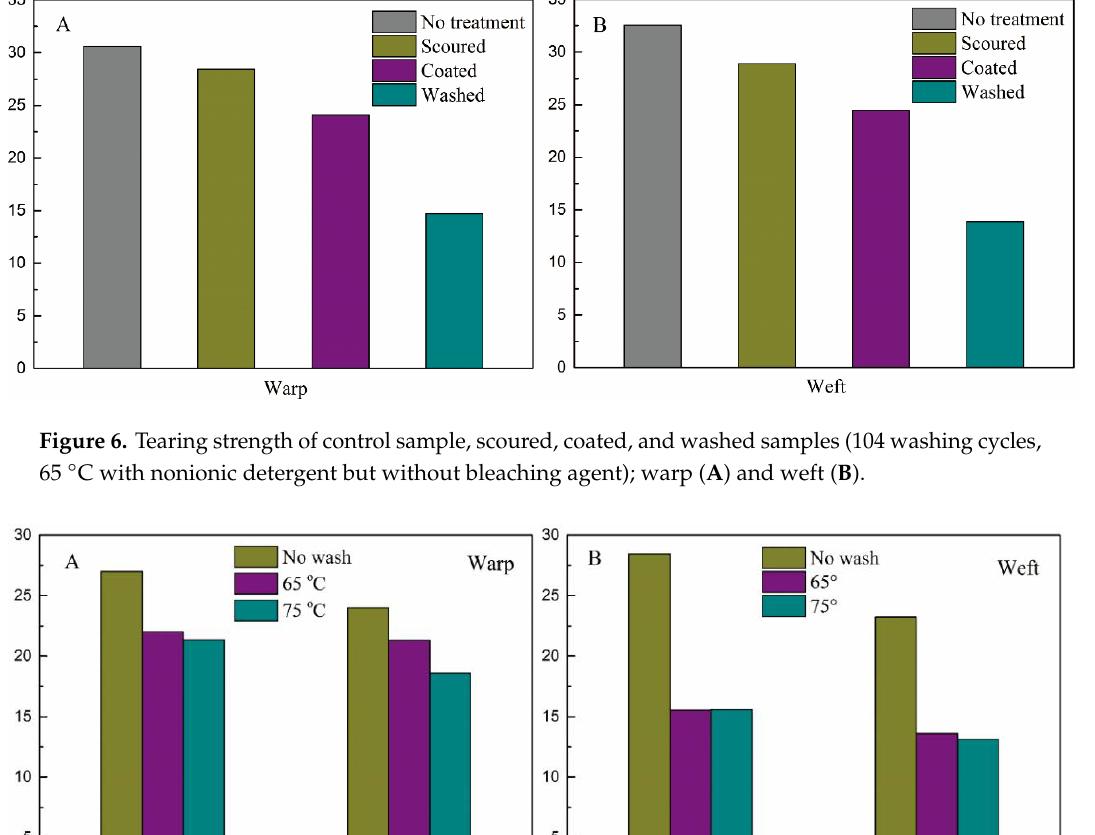
Figure 7. Tearing strength of control and treated samples after 52 washing cycles at 65 °C and 75 °C, warp.